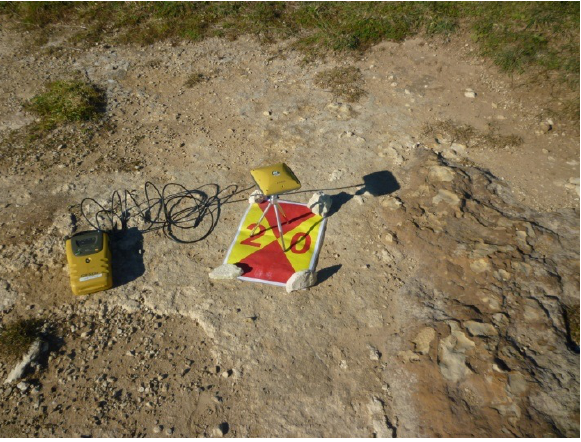
Figure 4: Ground Control Point (GCP)